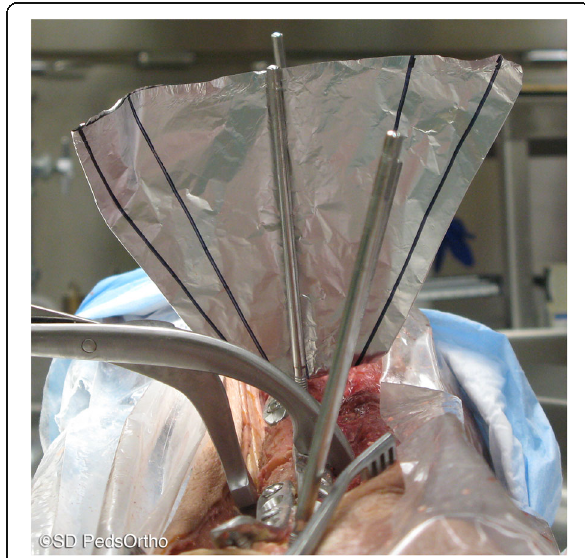
Fig. 2 External rotation through a middle level femoral osteotomy measured by pins placed in adjacent segments of the osteotomy. The more distal segment is rotated externally by 20 degrees, and then held in place with a plate and locking screws